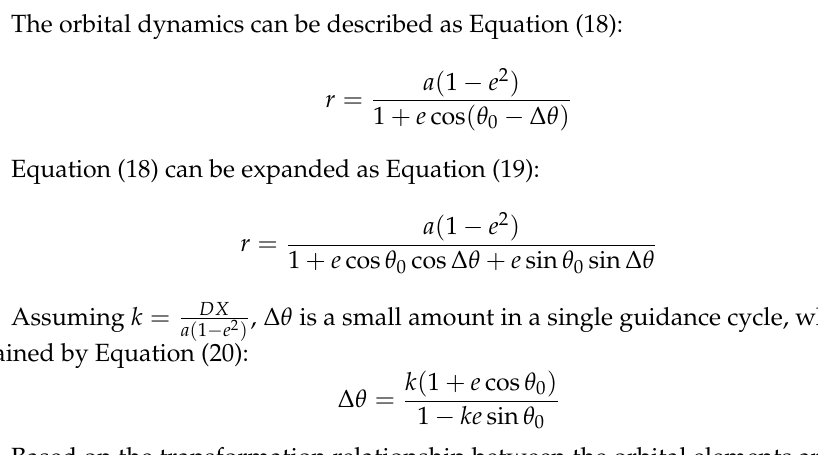
The orbital dynamics can be described as Equation